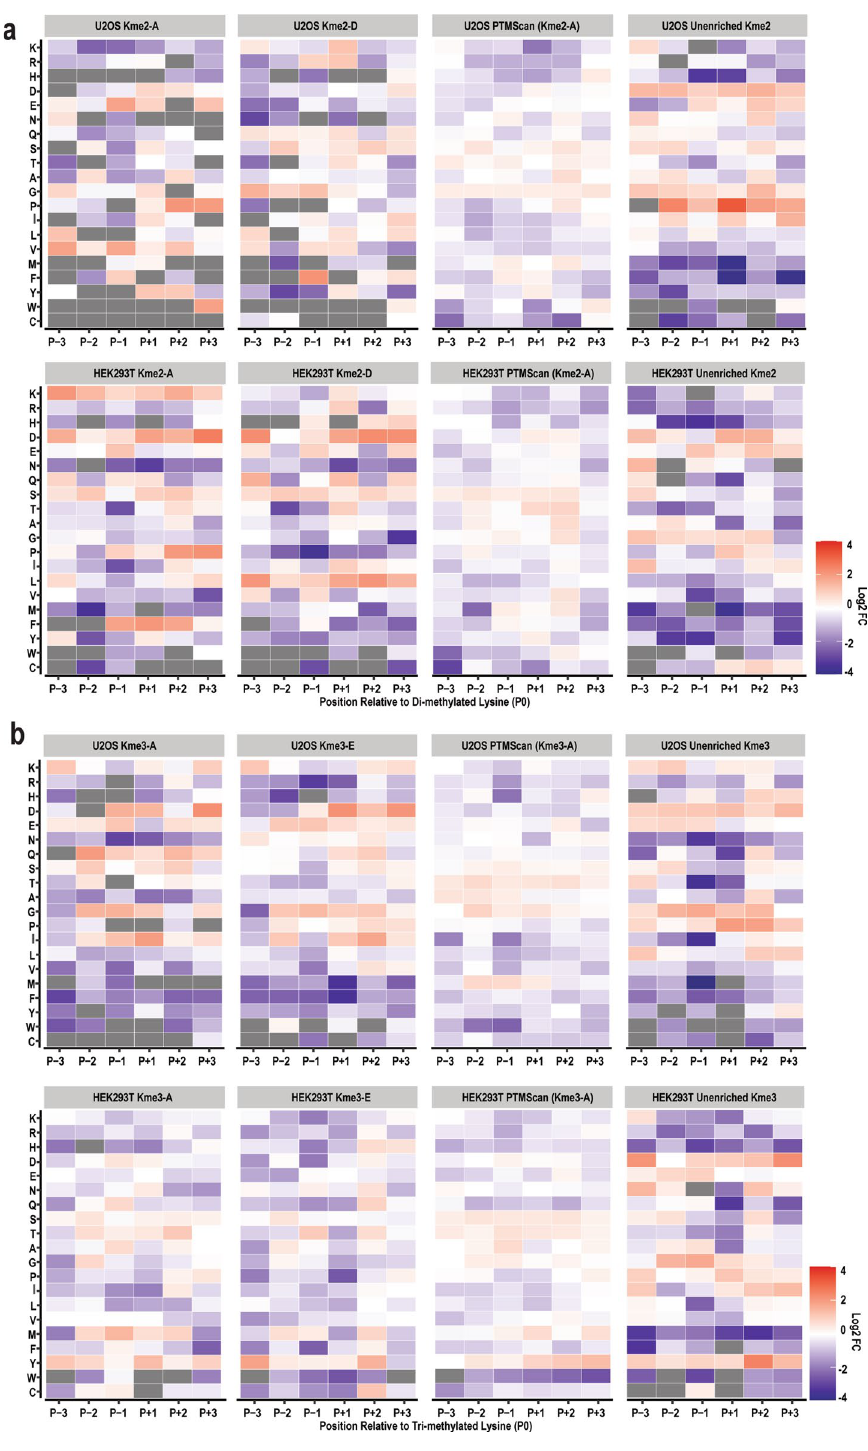
Figure 5. Comparison of sites detected by different pan-methyllysine antibodies. Heatmaps depicting the log 2 of the ratio of the frequency of amino acids seen in the 7-mer motifs of methylated peptides compared to the frequency of amino acids seen in the 7-mer motifs of all lysine residues on every protein detected in unenriched samples. Gray squares indicate that the amino acid in that position was not detected on any peptide. ( a ) Di-methyl lysine peptides identified using enrichment with Kme2-A, Kme2-D, PTMScan, or no enrichment as indicated from U2OS or HEK293T cell lysates. ( b ) Tri-methyl lysine peptides identified following enrichment with Kme3-A, Kme3-E, PTMScan, or no enrichment as indicated from U2OS or HEK293T cell